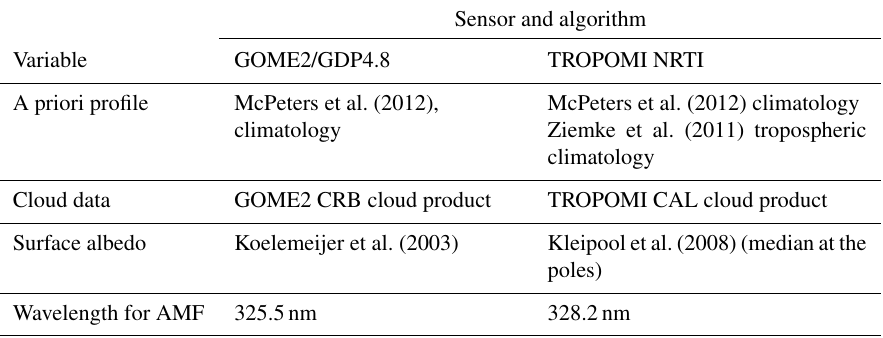
Table 3. Summary of the main differences between the TROPOMI NRTI and GOME2 GDP4.8 algorithm.